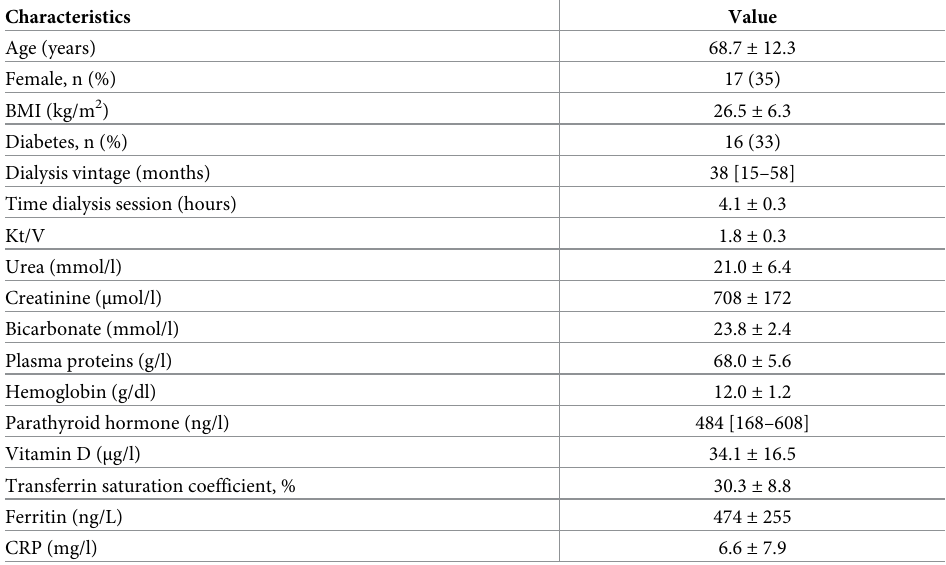
Table 1. Baseline characteristics.